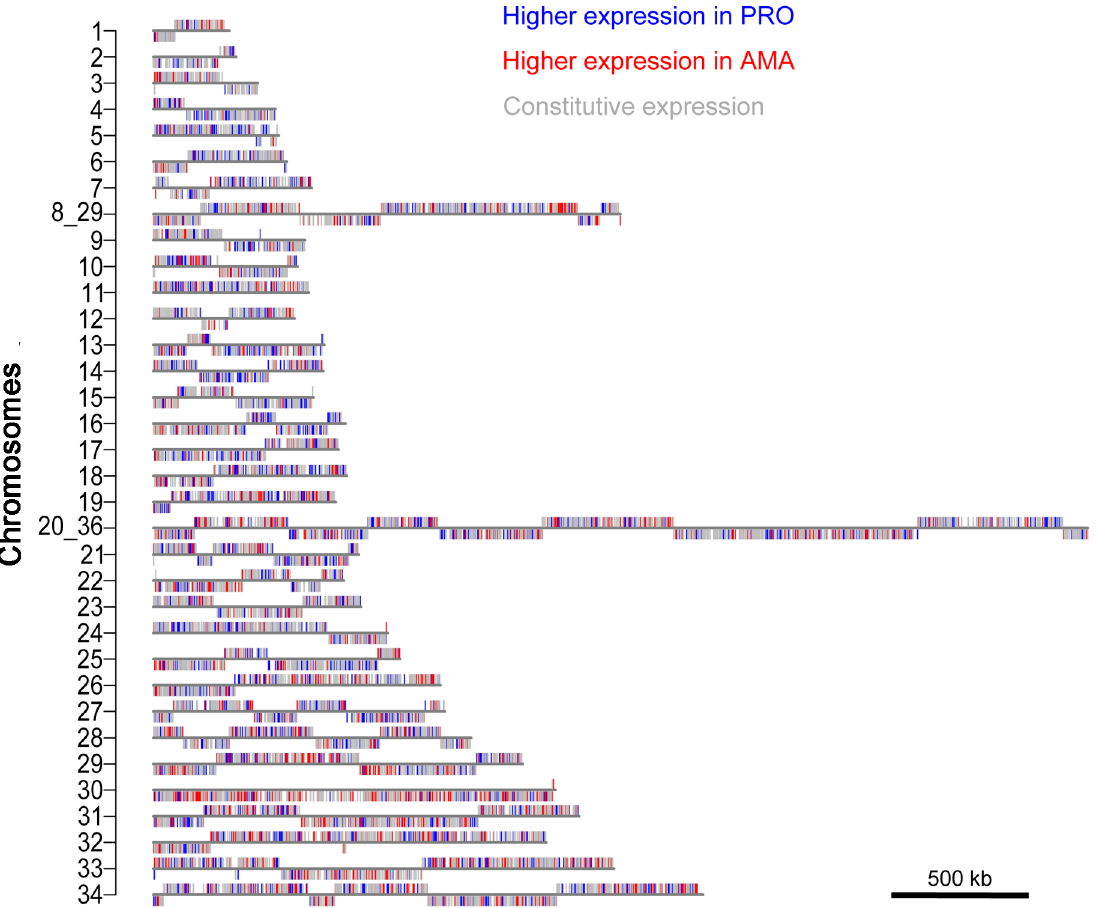
Fig 8. Distribution of differentially expressed genes across chromosomes. Maps of the 34 L . mexicana chromosomes show the location of genes that are preferentially expressed in AMA (red), PRO (blue) or constitutively expressed (grey).